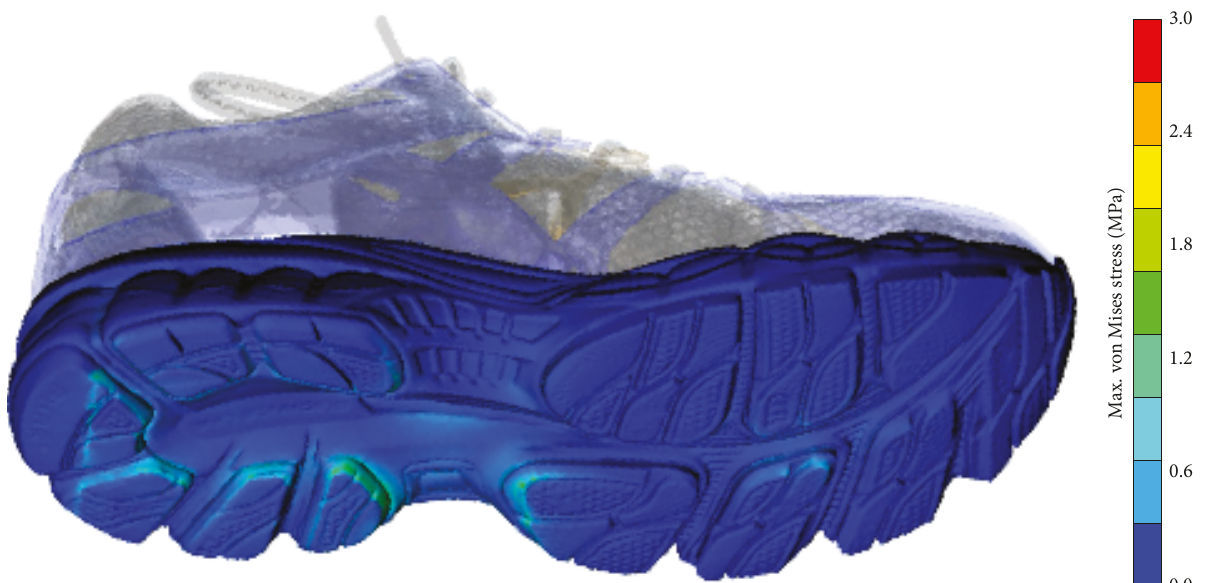
Figure 6: Equivalent von Mises stress distribution during an intermediate step of impact peak.